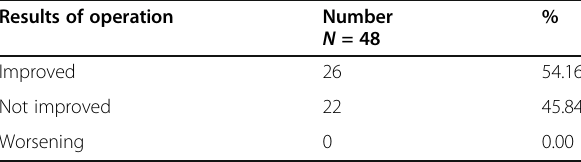
Table 7 The operation results of patient with nasal symptoms Results of operation